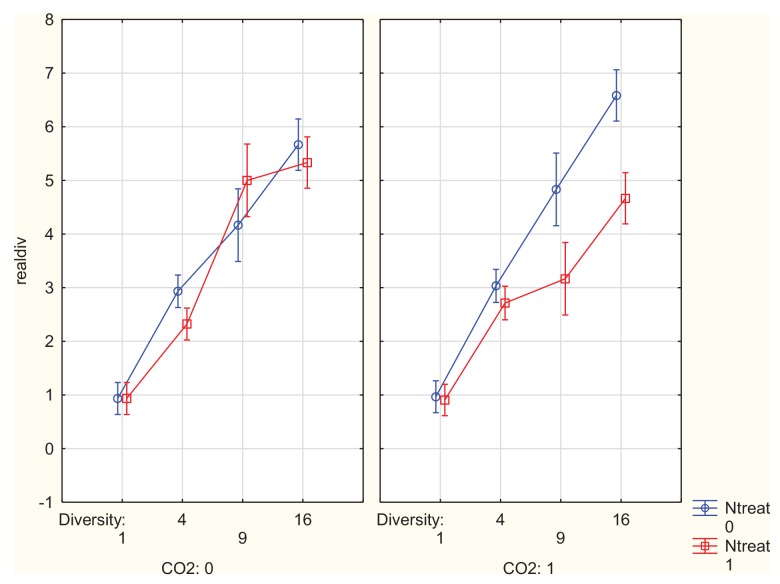
Plant species richness, N addition, and CO2 effects on realized species richness in the BioCON experiment.For statistical results see main text. Means with 95% confidence intervals.